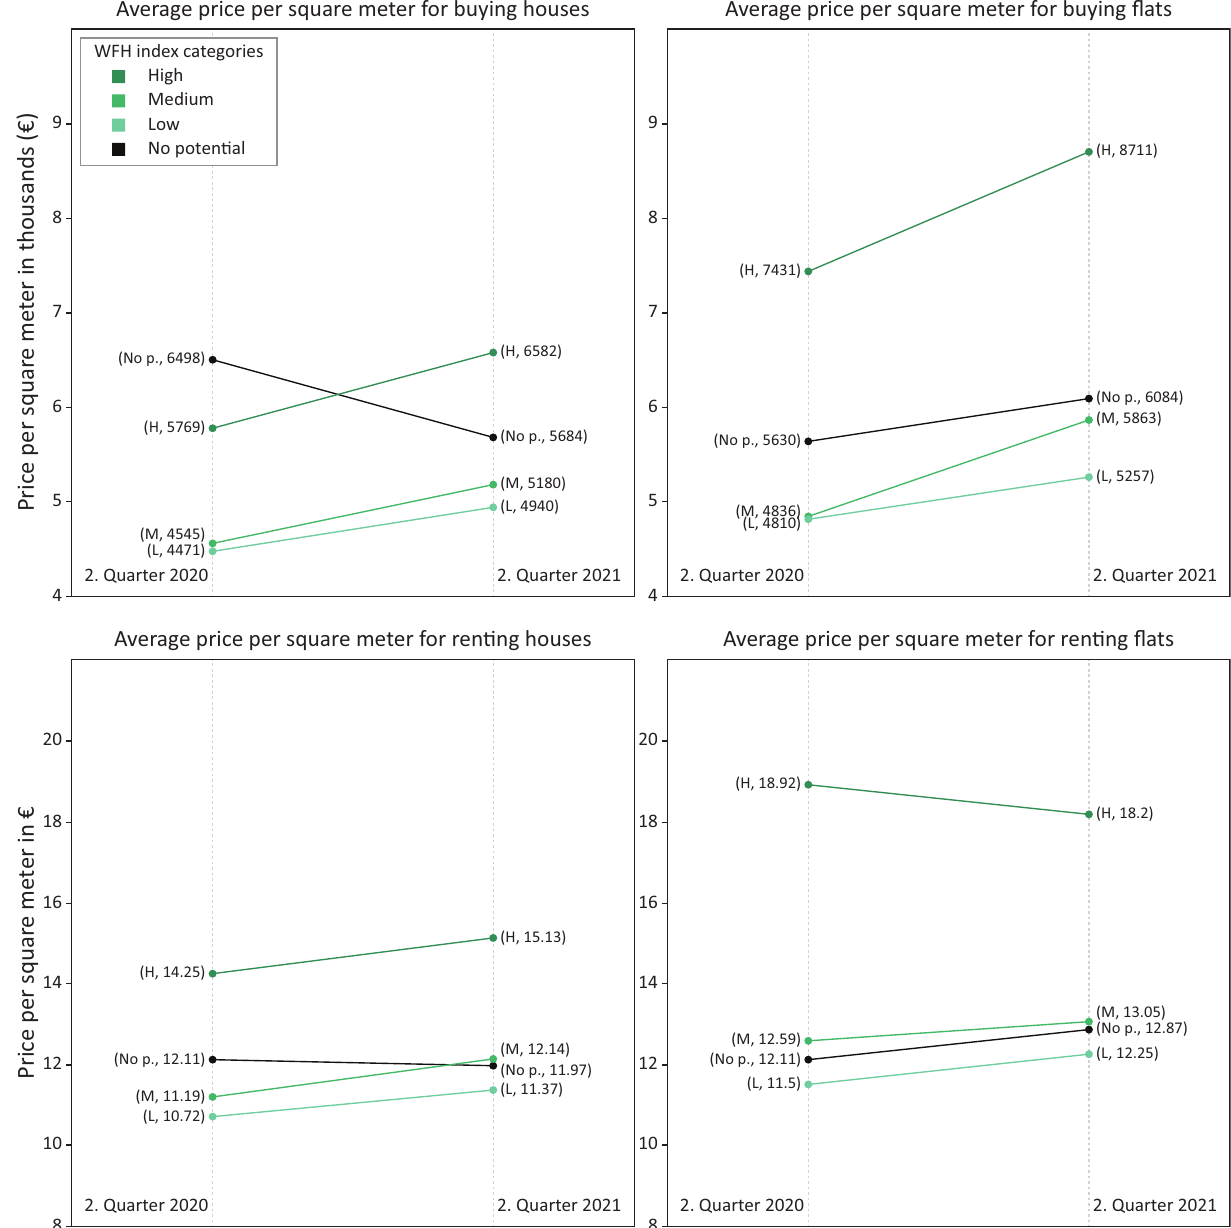
Figure 11. Comparison of average housing price developments from April–June 2020 to April–June 2021, differentiated according to WFH index categories. Notes: For “house purchases,” there are 5,217 observations in 2020 and 3,566 in 2021; for “flat purchases” 6,675 observations in 2020 and 5,480 in 2021; for “renting houses” 1,671 in 2020 and 1,281 in